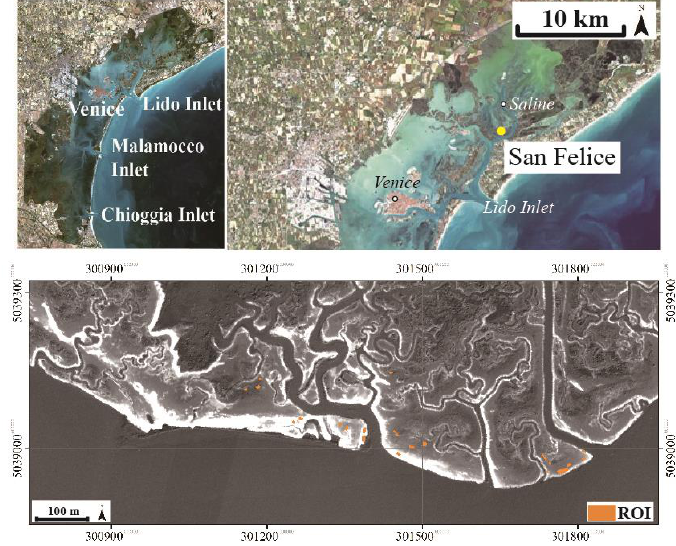
Figure 1. Research area: the top panels show the map of the Venice lagoon and the position of Felice salt marsh; the bottom panel shows the map of the San Felice marsh acquired by WorldView-2 (WV-2) (Red Edge, central wavelength: 724 nm) in 2019 and the positions of the regions of interest (ROIs).